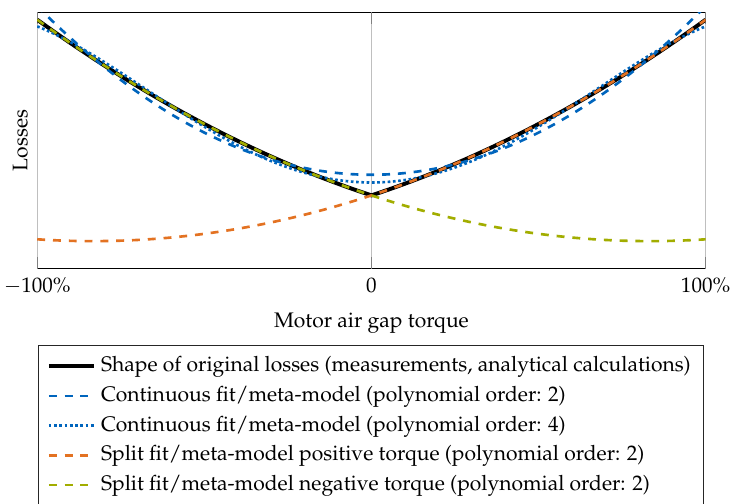
Figure 2. Fitting concepts for losses with V-shape. Continuous fits fail to fit the point around zero torque, even for high polynomial